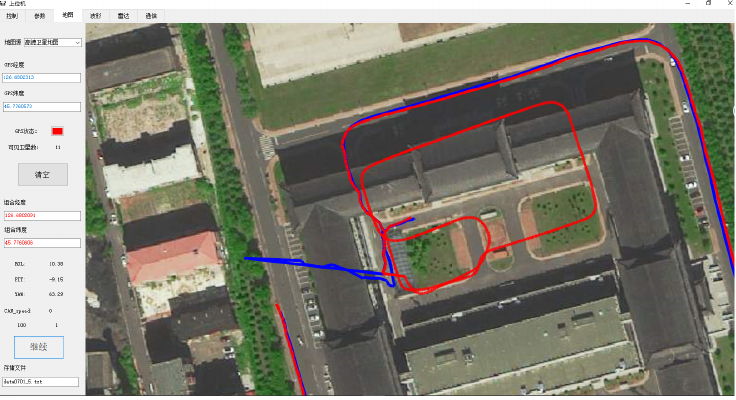
Figure 10. GPS-MEMS EKF trajectory comparison